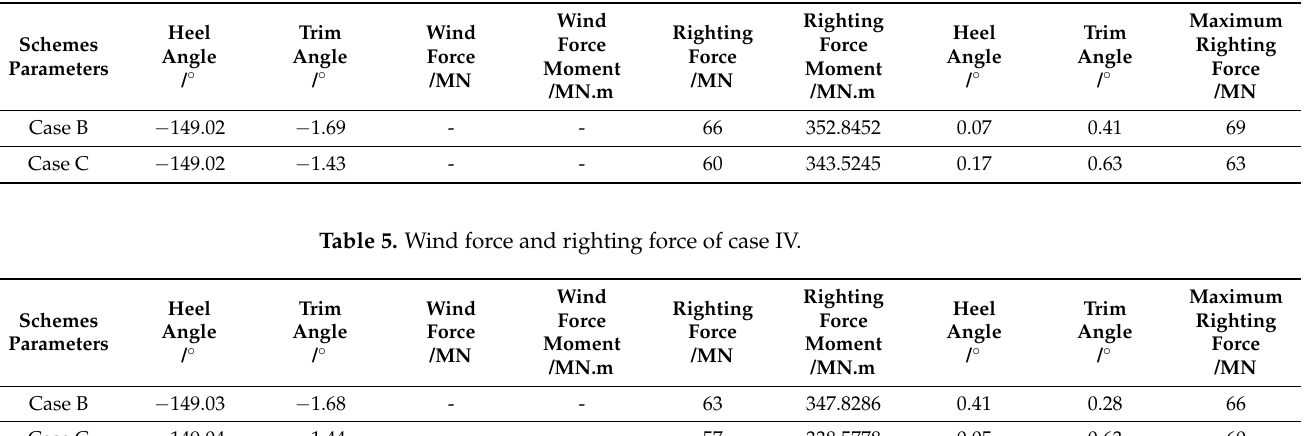
Table 4. Wind force and righting force of case III.